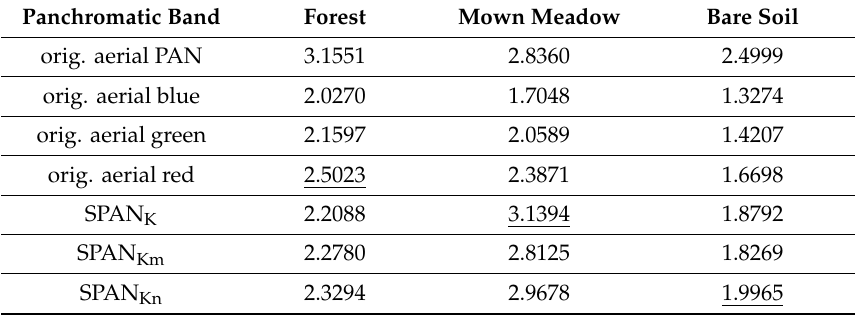
Table 5. Entropy values for original aerial panchromatic band, new simulated (the best results are